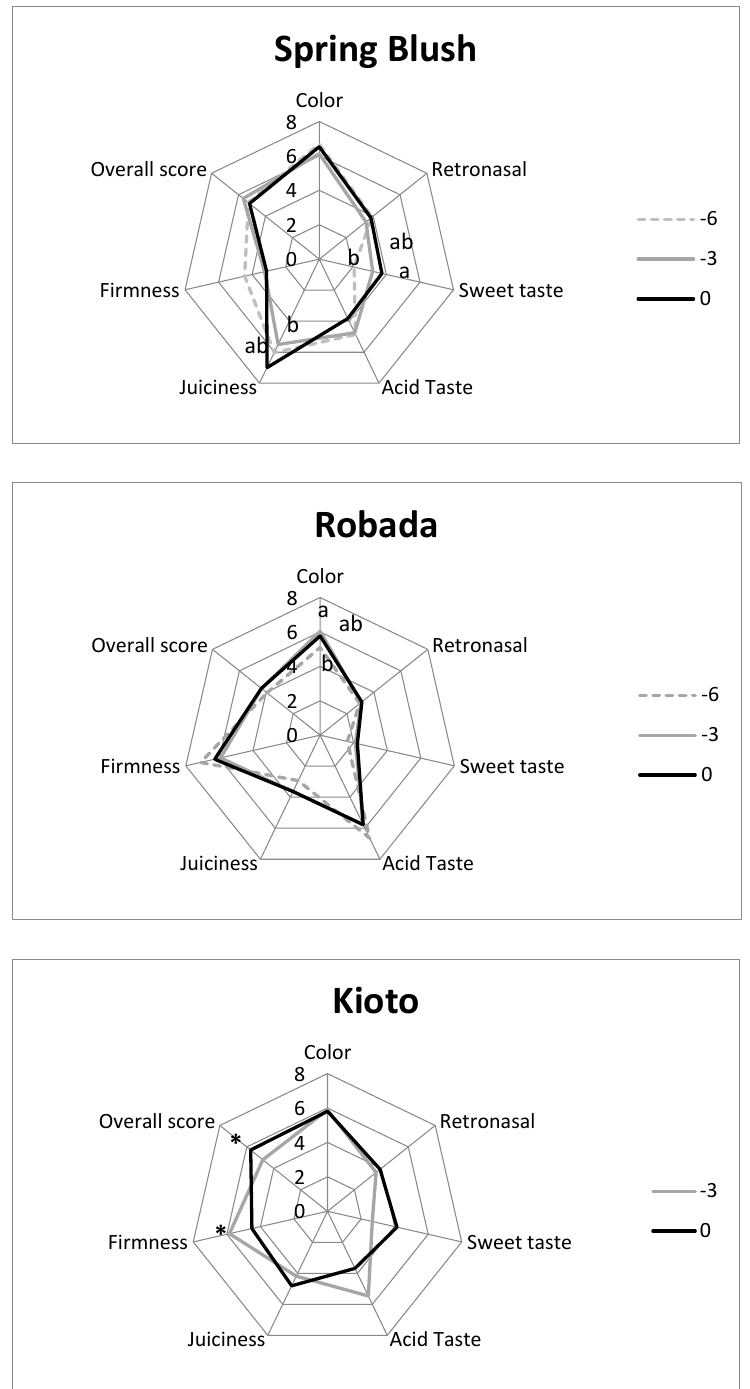
Figure 9. Sensory evaluation results. For each quality parameter, samples with different letters or marked with asterisks differ at a significance level of 0.05 according to the Tukey test (n = 12).